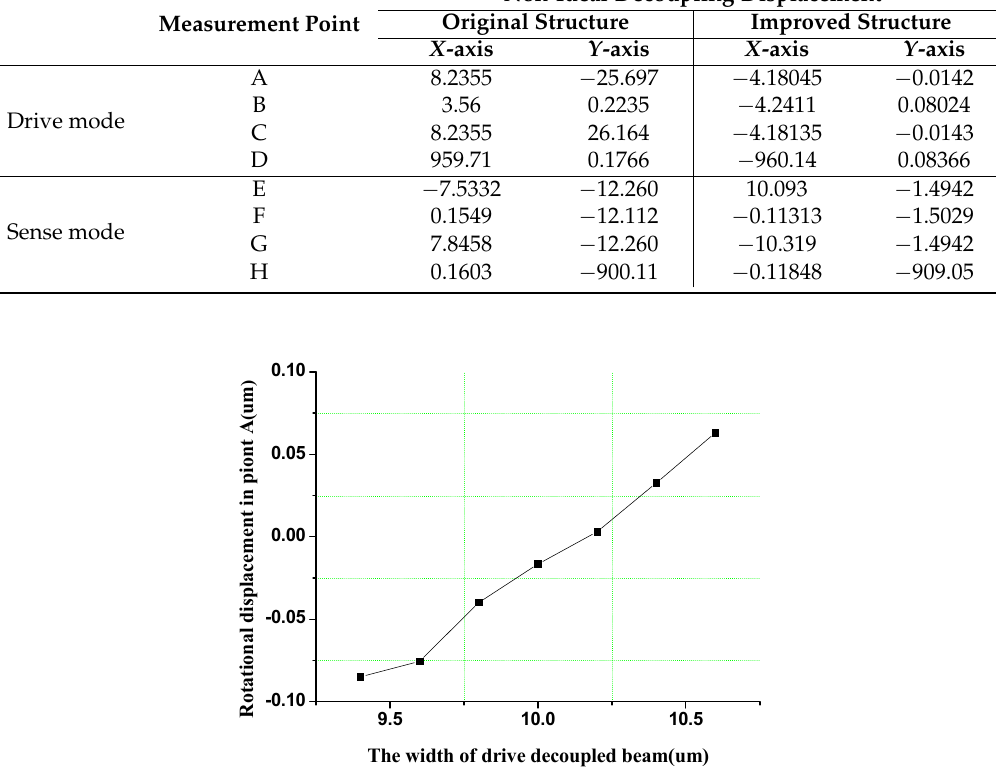
Table 3. Non-ideal decoupled displacement in the drive and sense modes.